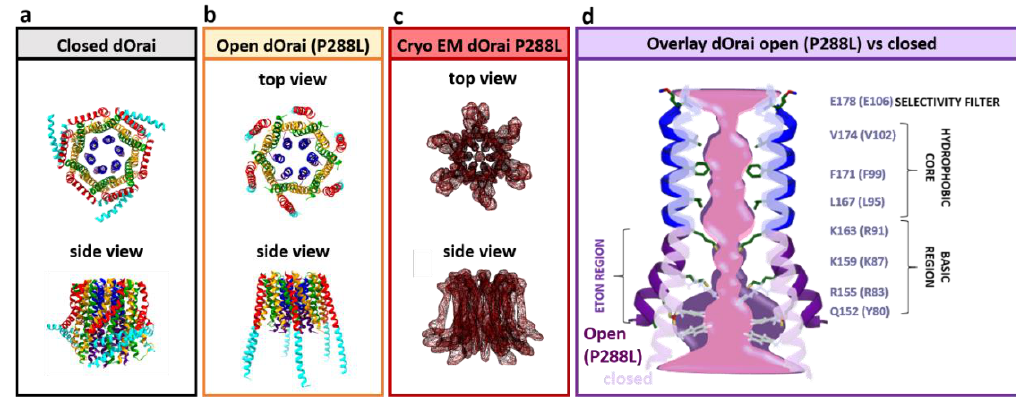
Figure 4. Closed versus open dOrai structure and pore architecture. ( a – c ) The top and corresponding side view of the dOrai channel crystal structure of the closed state ( a ), open state (P288L) (PDB ID: 6AKI) ( b ) and cryo EM structure of the open state (P288L) ( c ) are depicted. ( d ) The pore region of the closed state (light-colored TM1 helices) and the corresponding pore profiles are depicted in pink. The structure is overlaid by an open pore structure of dOrai P288L (dark blue and purple TM1 helices) while its pore architecture is depicted in dark purple color.